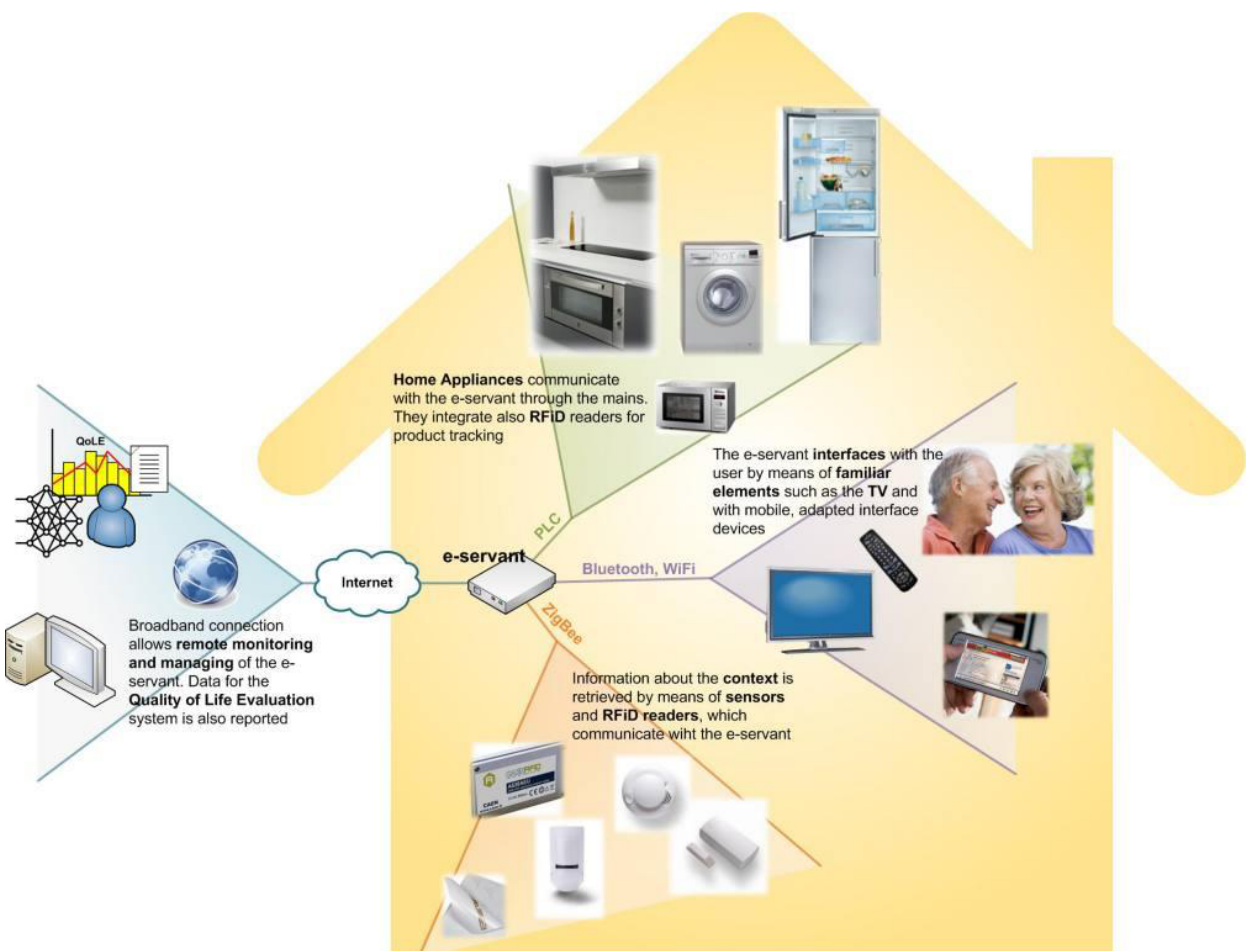
Figure 4. EasyLine+‘s system